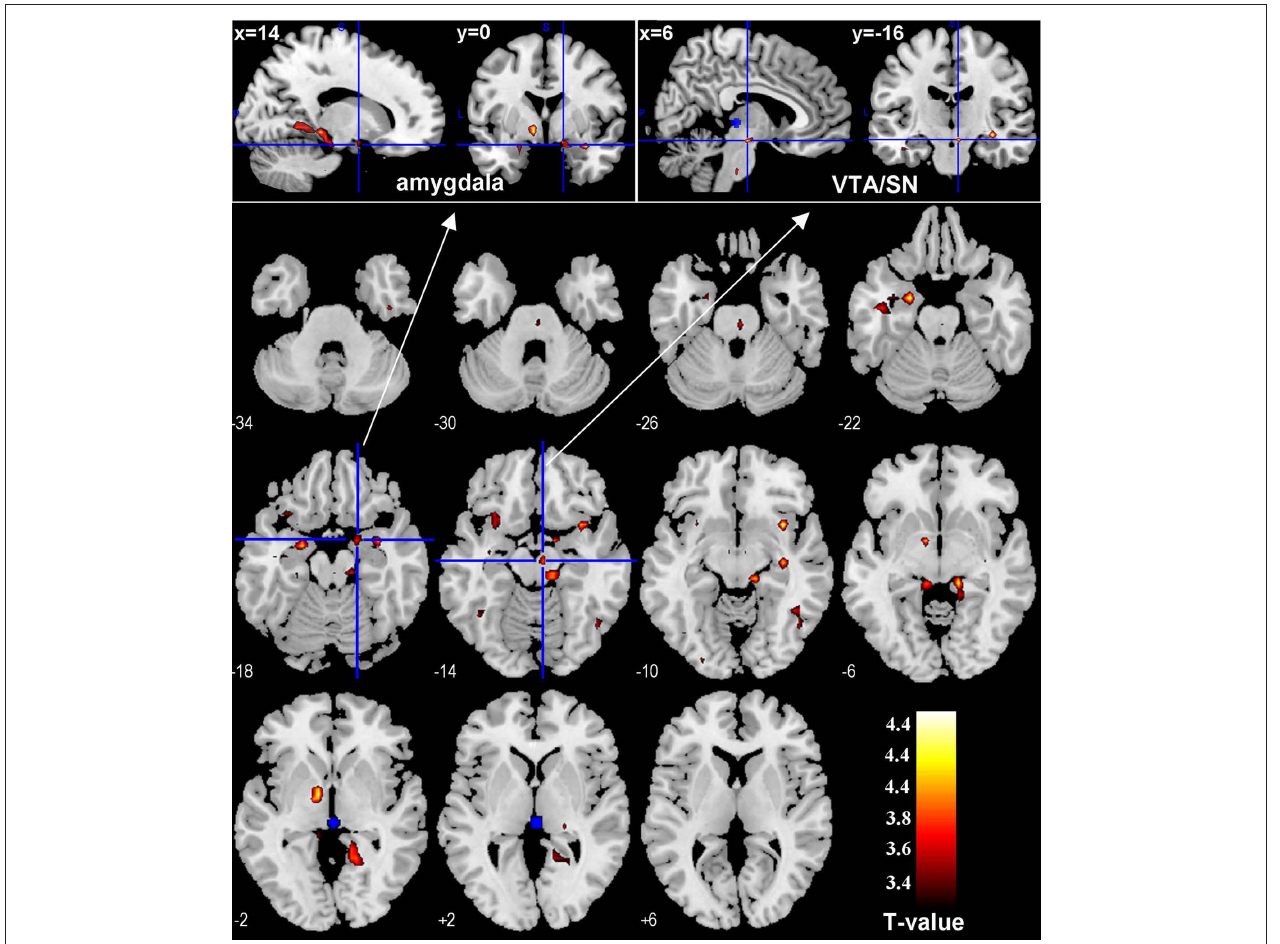
tegmental area/substantia nigra (VTA/SN, right) on sagittal and coronal sections. Interestingly, this VTA/SN cluster has little overlay with error-related activations in the midbrain area (see inset in Figure 1 ), i.e., these identified dopaminergic midbrain clusters were mostly not activated during stop error > stop success.